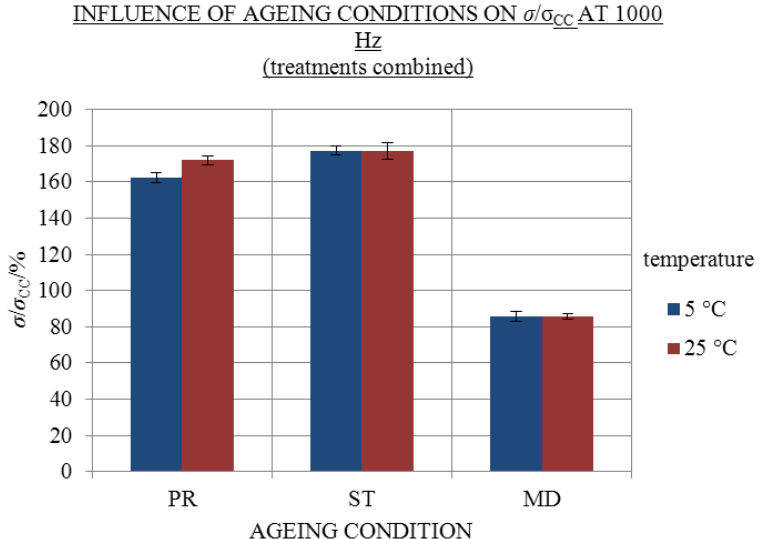
Figure 8. Influence of ageing conditions PR, ST and MD on average σ / σ intervals measured at 1000 Hz 25 (red) and 5 °C (blue) (treatments combined); number of replicate solutions, N (/): PR (28), ST (20), MD (20). Solutions aged for 310 days.